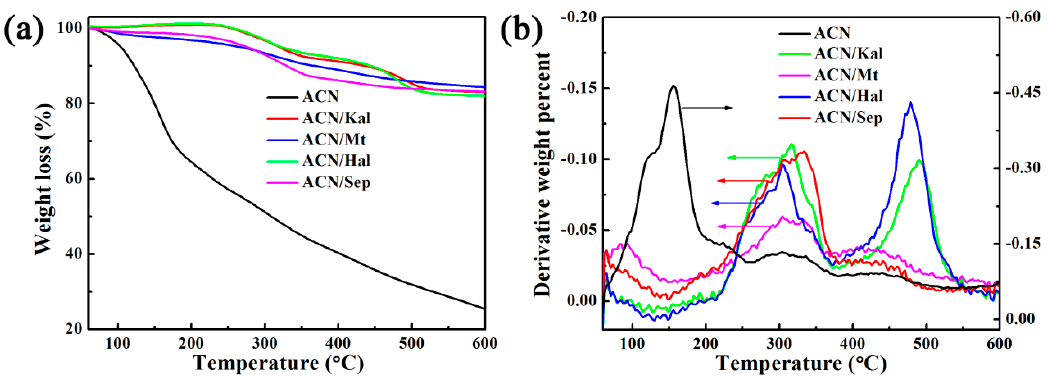
Figure 5. TGA ( a ) and DTG ( b ) curves of ACN extracted from blueberry and hybrid